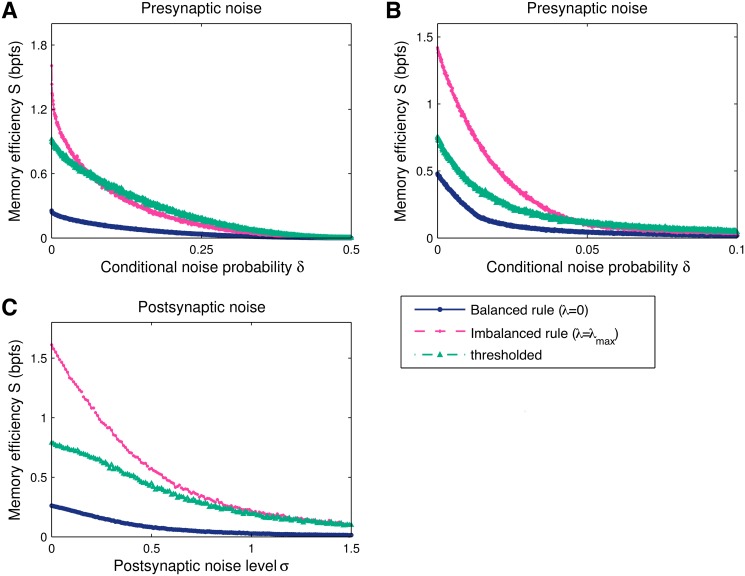
Information C and memory efficiency S versus noise level.The three solutions — balanced (λ = 0) and maximally-imbalanced (λ = λ
max) plasticity, and thresholded synaptic pruning — were obtained once for a single set of K = 0.1N positive patterns (N = 1000 synapses) and then tested against a large number 100K of distorted learned patterns and lures, generated for each noise level. The firing threshold of each solution is numerically optimised to maximise information. The presynaptic noise level varied under the setting δ
01 = δ
10 = δ (see main text for details). The scale of the postsynaptic noise standard deviation was set by normalising the weights to give a unit size mean response to learned patterns. A. For dense patterns, f = 1/2, the falloff in information is steeper for imbalanced plasticity than thresholded deletion. The two solutions remain more efficient than balanced learning for all noise levels. B. For sparse input patterns, f = 0.01, the balanced solution also suffers and as long as the information is not practically zero, both the maximally-imbalanced and the thresholded pruning rules are more efficient than the balanced one. C. Results for a postsynaptic noise model, where the current h is perturbed with an additive zero-mean Gaussian random variable with standard deviation σ. As the postsynaptic noise does not depend on the actual learned weights, imbalanced and balanced plasticity show similar noise robustness profiles.